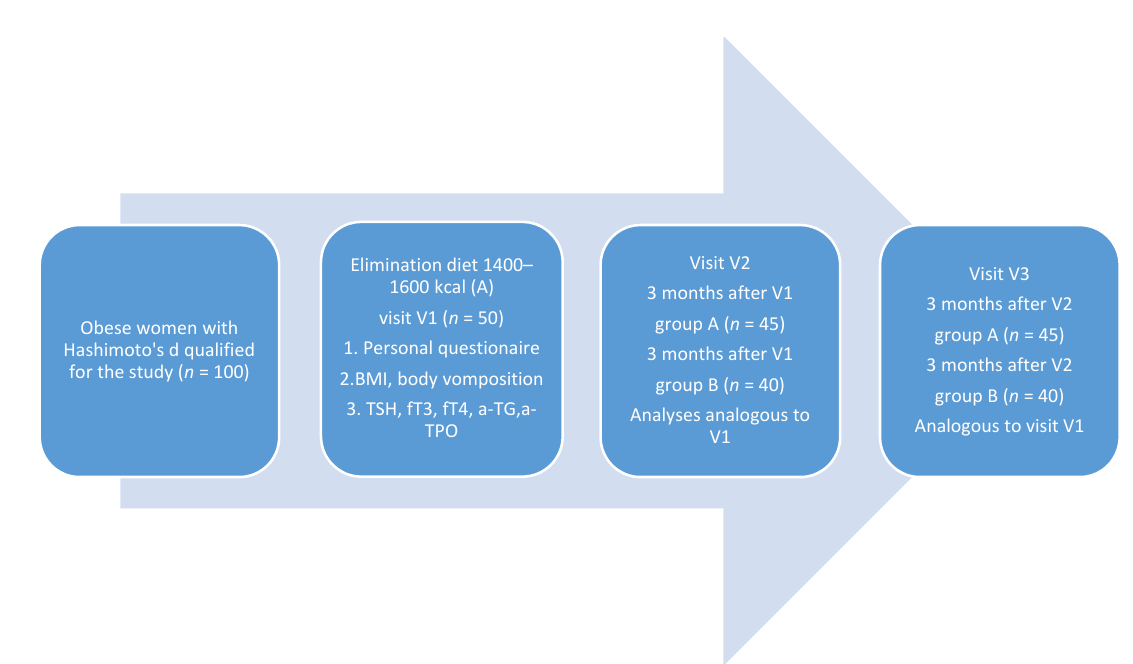
Figure 2. Experimental design. 100 obese women with Hashimoto’s disease were selected for the study. Stage 1 of the study (V1) included the completion of a personal questionnaire, assessment of body weight, height, and BMI, body composition analysis, biochemical tests: TSH, fT 3 , fT 4 , anti-TG, anti-TPO. Elimination diets of 1400–1600 kcal were recommended to fifty women (group A), while reducing diets of 1400–1600 kcal were recommended to the remaining 50 women—(group B). Stage 2 of the study (V2) began after 3 months and included analyses analogous to those conducted during V1. It included 45 women following elimination diets and 40 women following reducing diets. Next, 3 months after V2, the last, third stage of the study (V3) was performed. This included 45 women from the elimination group and 40 women from the reducing group. The tests performed at this stage were analogous to the previous stages.